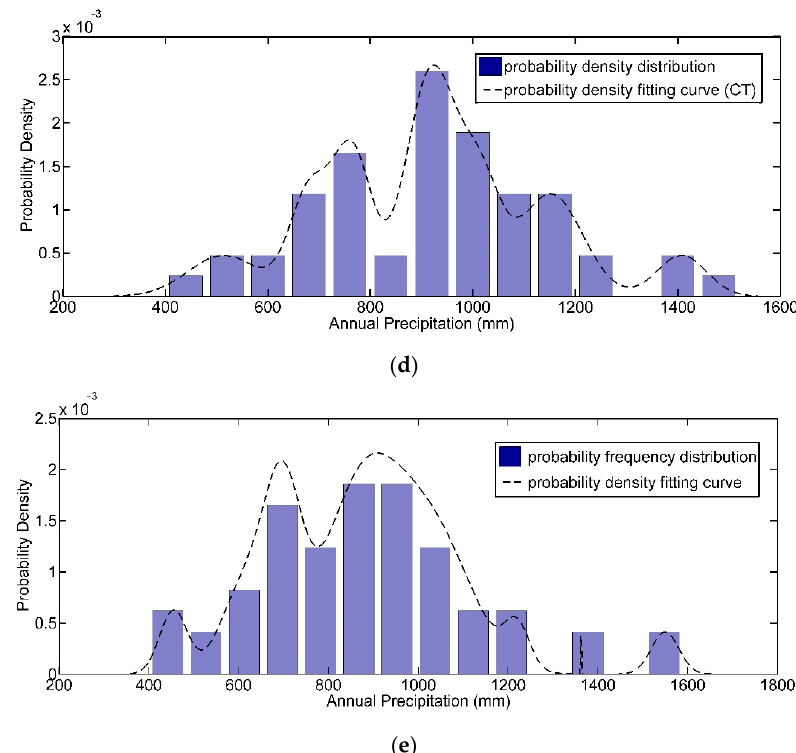
Figure 2. Distribution of probability density fitting curve of annual precipitation in north Anhui province, China. ( a ) Guoyangzha Station; ( b ) Dangshan Station; ( c ) Linquan Station; ( d ) Mohekou Station; and ( e ) Xifeihezha Station.